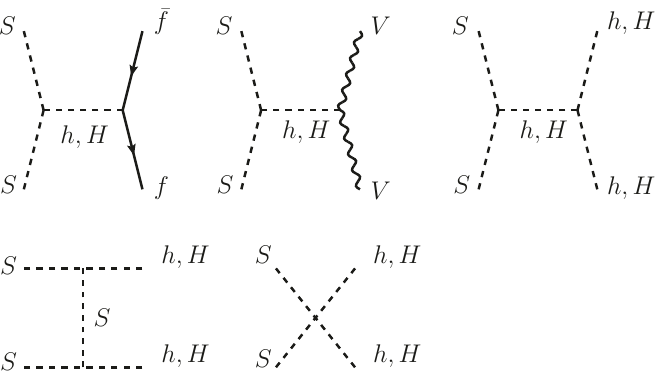
Figure 3 . Feynman diagrams for the DM